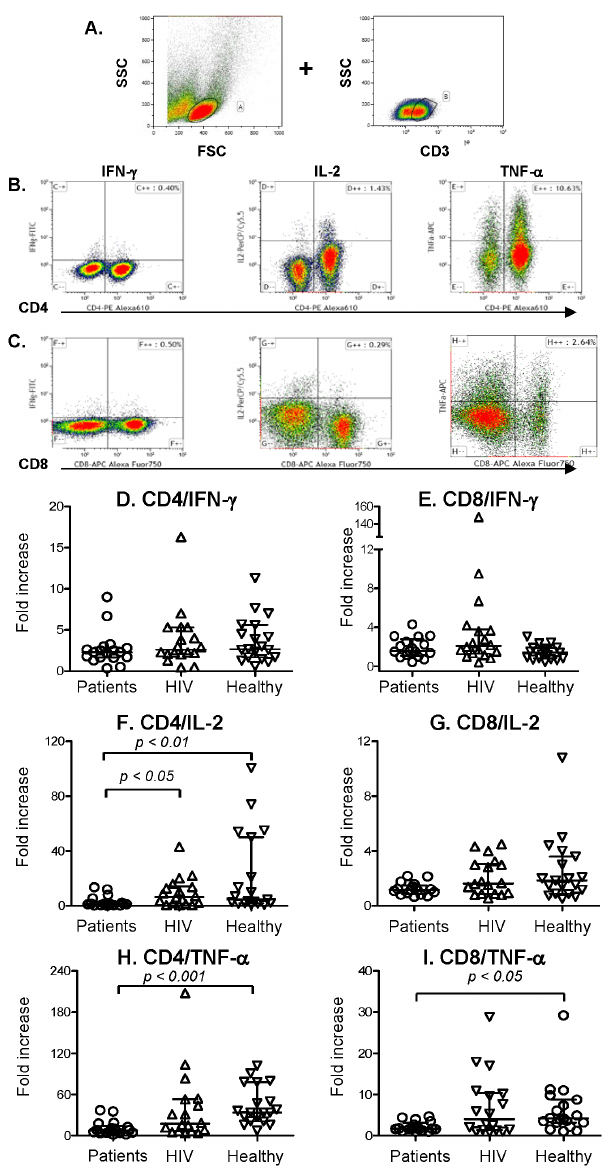
Figure 2. Cytokine production by CD4 and CD8 T cells, by CD4 and CD8 T-cell types, and by fold increase upon stimulation. PBMCs were stimulated by phytohemagglutinin or by no mitogen stimulant for 24 hours. Cells were harvested and stained with fluorochrome conjugated CD3, CD4, CD8, IFN- c , IL-2 or TNF- a mAbs. PBMCs were gated by forward and side scatter and the CD3 + T lymphocyte population was identified (A). IFN- c , IL-2 or TNF- a expression in CD4 + T cells (B) or CD8 + T cells (C) were then examined. Figures 2D and 2E show fold increase of IFN- c , Figures 2F and 2G fold increases of IL-2, and Figures 2H and 2I fold increases of TNF- a production in response to PHA, compared to cells cultured with no mitogen stimulant. Symbols represents the data of each individual case patient (circles), HIV + control (up-pointing triangles), and healthy control (down-pointing triangles). Long horizontal lines show the medians, and short lines the interquartile ranges of each group. Indicated p values for comparisons are by Kruskal-wallis one-way analysis of variance by rank test.